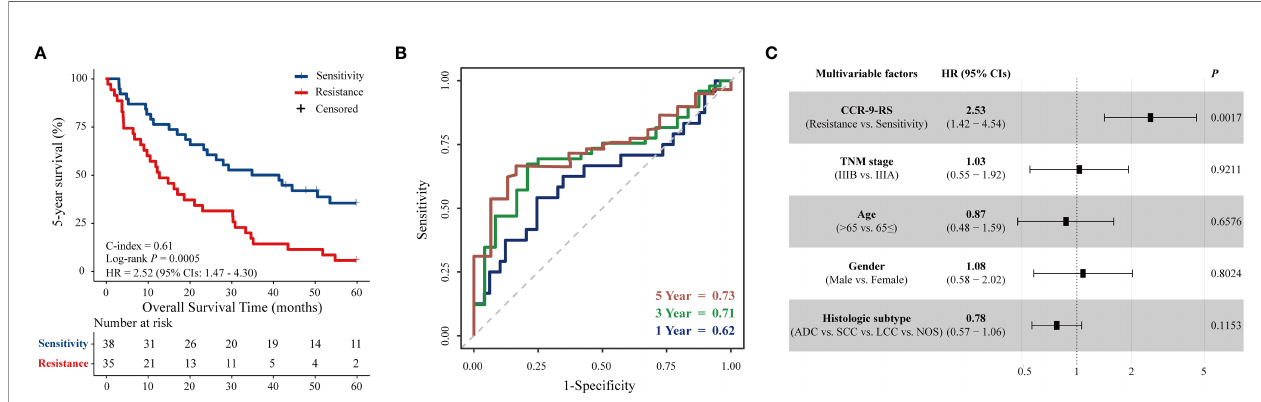
FIGURE 3 | Validation of CCR-9RS. (A) Kaplan – Meier curves of 5-year survival rate for patients in the validation dataset ( n = 73). (B) Time-dependent receiver operating characteristic curve (ROC) of CCR-9RS in predicting 1-, 3- and 5-year survival rates in the validation dataset. (C) Multivariate Cox analyzes of CCR-9RS after adjusting for clinical factors in the validation dataset.